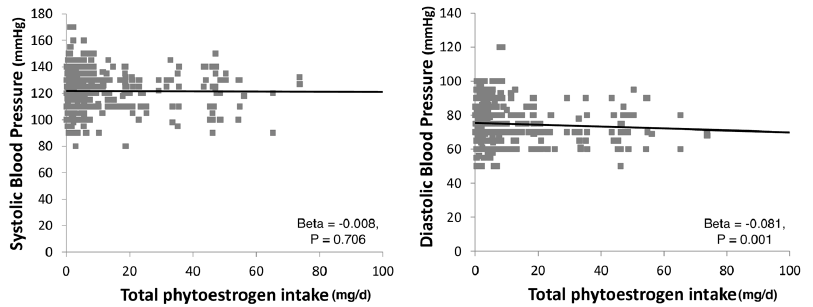
Figure 1. Association between dietary phytoestrogen intake and systolic and diastolic blood pressure (BP). Table 2. Association between quartiles of dietary phytoestrogens intake (total and main classes) and hypertension. The association between quartiles of total and individual phytoestrogen intake and hypertension is reported in Table 2.